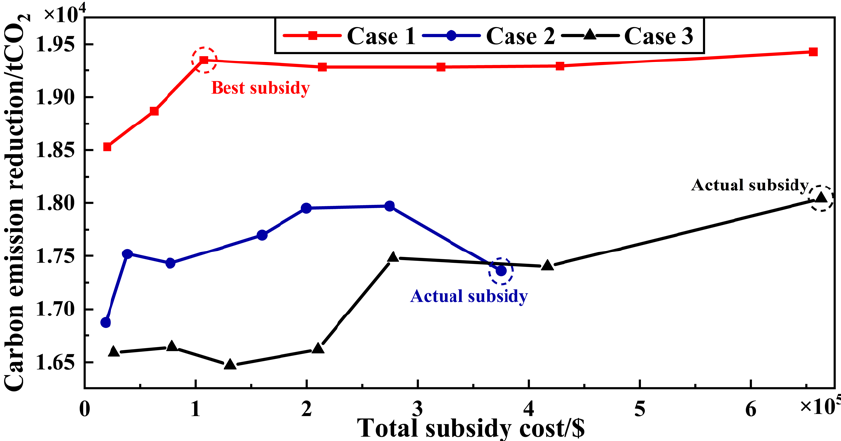
relationship between carbon reduction and total subsidy cost in three cases is shown in Figure 13.